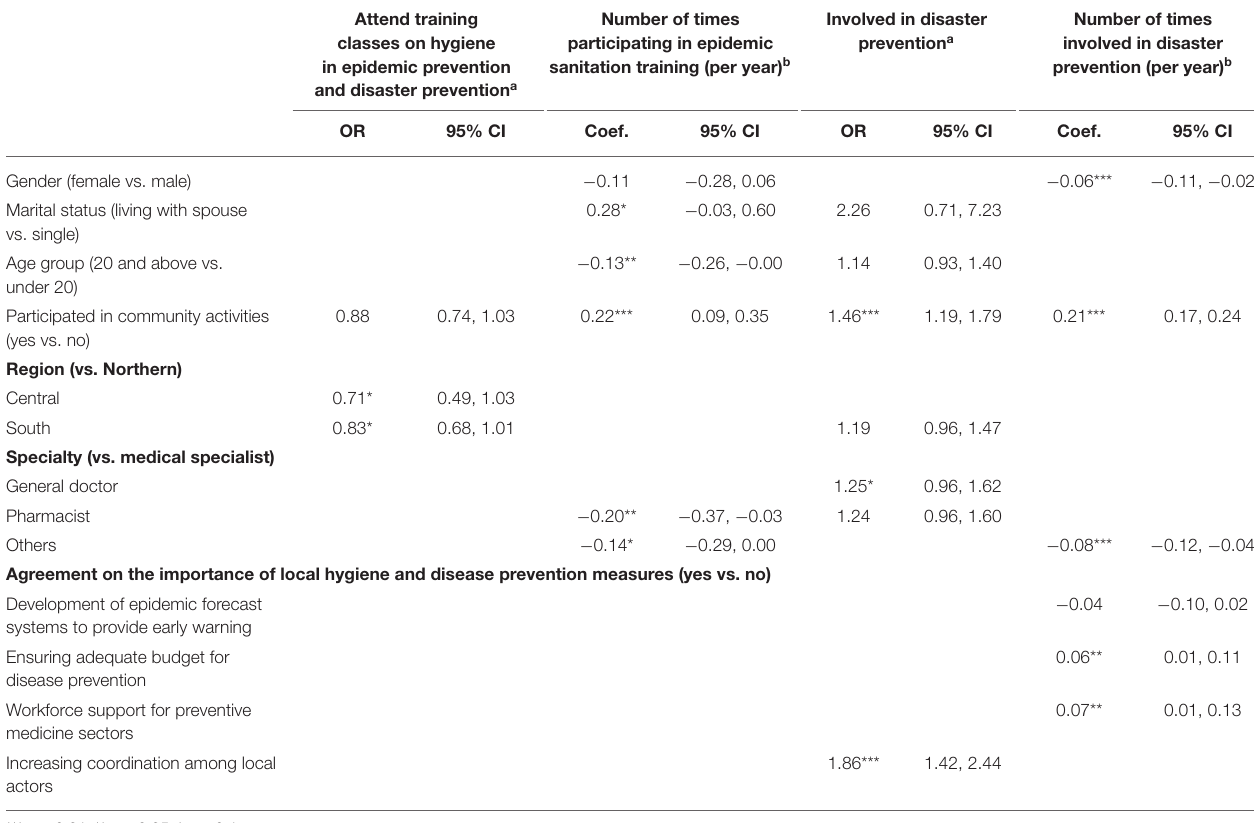
TABLE 4 | Associated factors with training and practice for epidemic control among medical